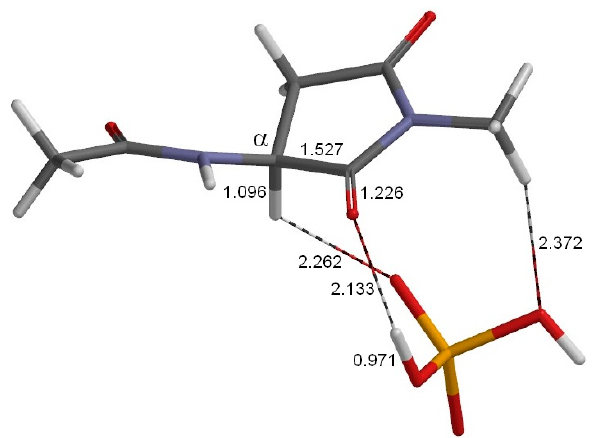
Figure 3. The geometry of the reactant complex RC ( φ = 179°, ψ = − 137°, χ 1 = 131°). This complex is formed between the model compound (Figure 1) and an H 2 PO 4 − ion. Selected interatomic distances are shown in Å. Grey: carbon; white: hydrogen; blue: nitrogen; red: oxygen; orange: phosphorus.